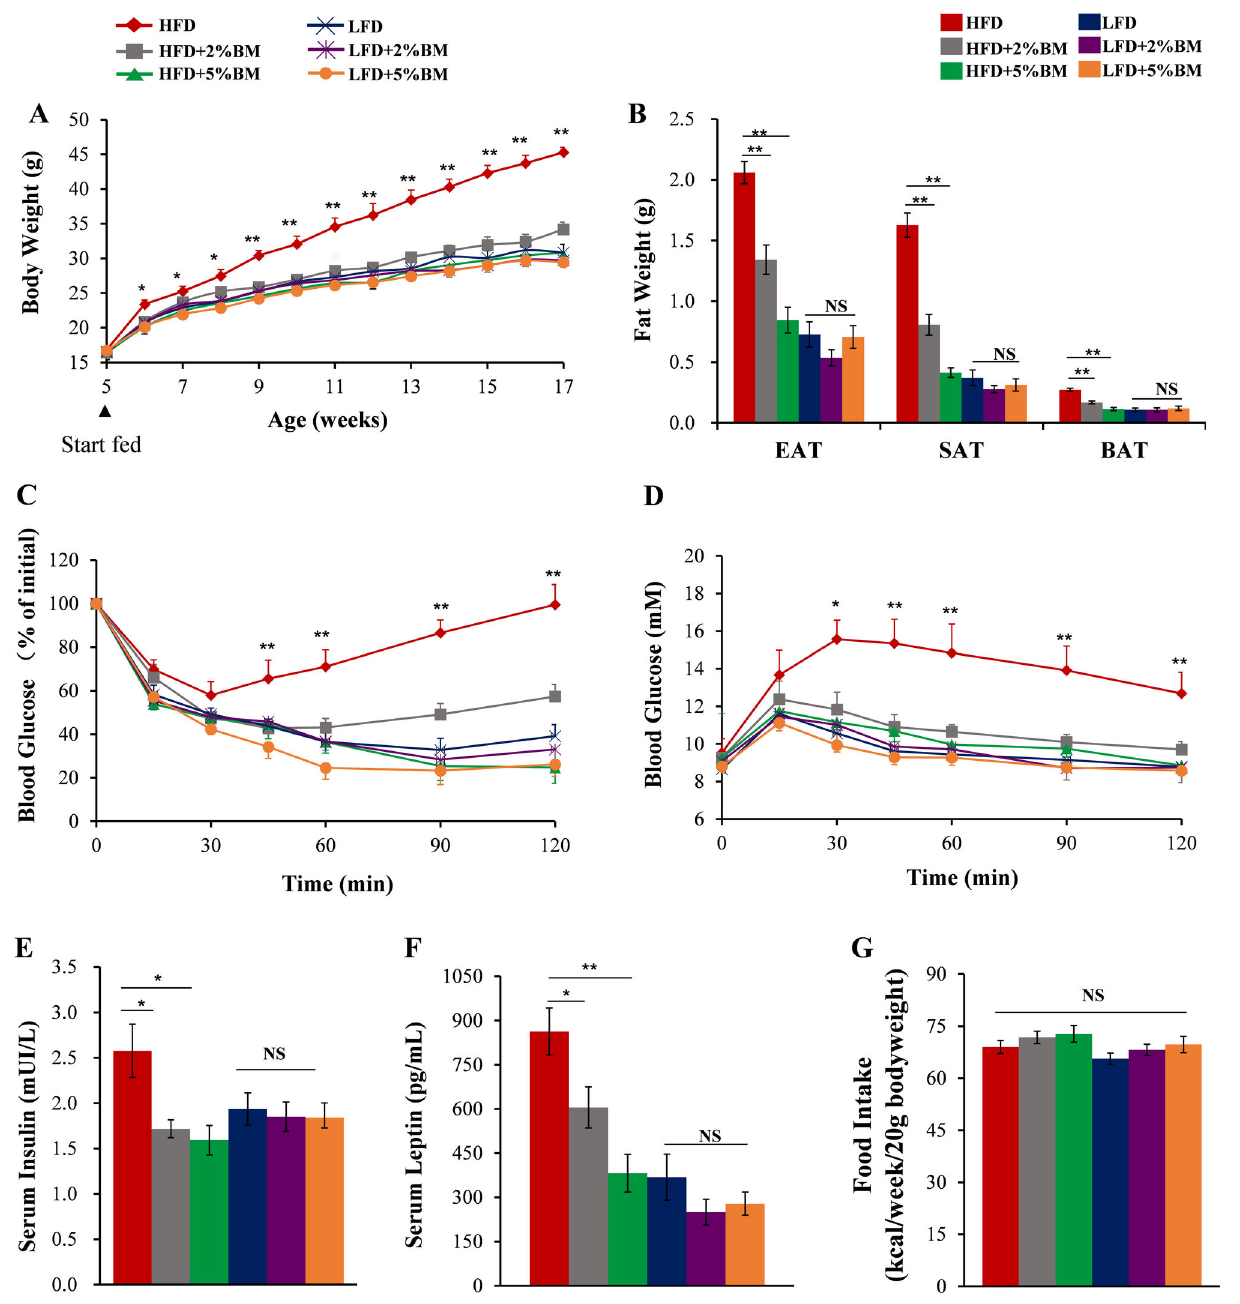
Figure 1. Bitter melon ameliorated fat deposition and insulin resistance in mice fed with HFD. Five-week-old male C57BL/6 mice were grouped and fed on the diets indicated in Table 1. (A) Body weight gain of the mice. (B) The weights of epididymal adipose tissues (EAT), subcutaneous adipose tissues (SAT) and brown adipose tissues (BAT) of the mice. (C) Insulin tolerance and (D) glucose tolerance assays were performed at 17-week-old in the mice. The insulin (E) and leptin (F) concentrations in serum of mice. (G) The energy intake per 20g bodyweight of mice during 12-week treatment. Statistical difference between groups is shown using a nonparametric Mann-Whitney test. n=8 per group. * P <0.05, ** P <0.01. All data are means ± SEM.